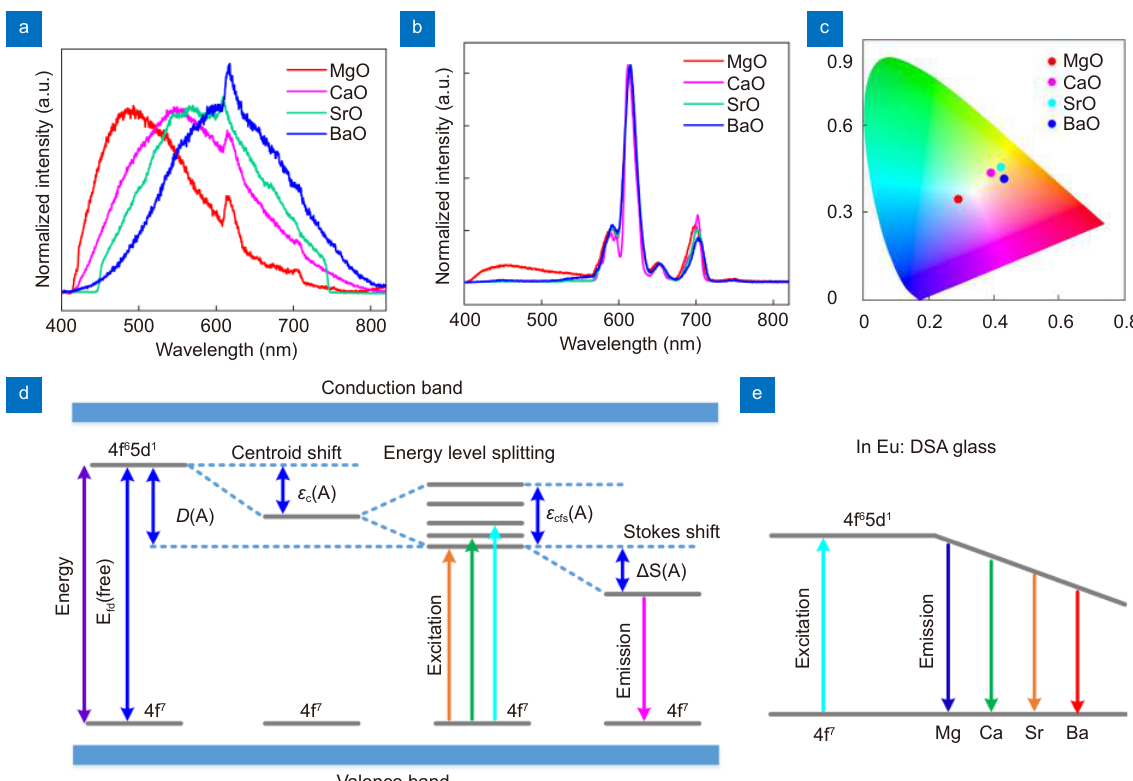
Fig. 5 | ( a ) PL spectra of dots written in the aluminosilicate glasses by fs laser. ( b ) PL spectra of initial glasses. Excitation wavelength: 375 nm. ( c ) Optical emission of Eu 2+ in CIE coordinates. ( d ) Schematic diagram of the real 5d energy position in an inorganic solid. ( e ) Spectroscopic red- shift in Eu: DSA